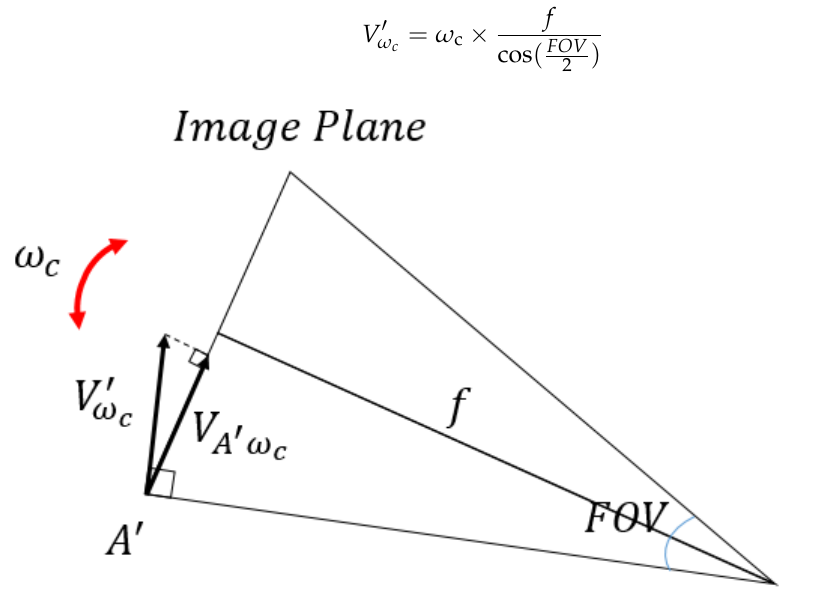
Figure 19 is a cross-sectional view of the image plane A (cid:48) point. The instantaneous linear velocity at the point A (cid:48) of the image plane during the pendulum scanning motion is